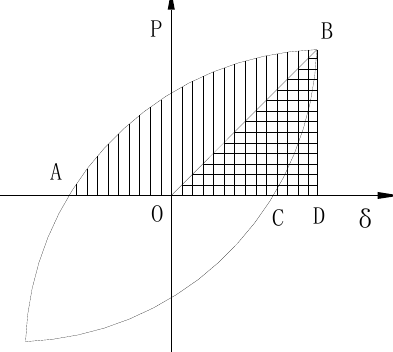
Figure 13. Calculated graphics of the equivalent viscous damping coefficient.